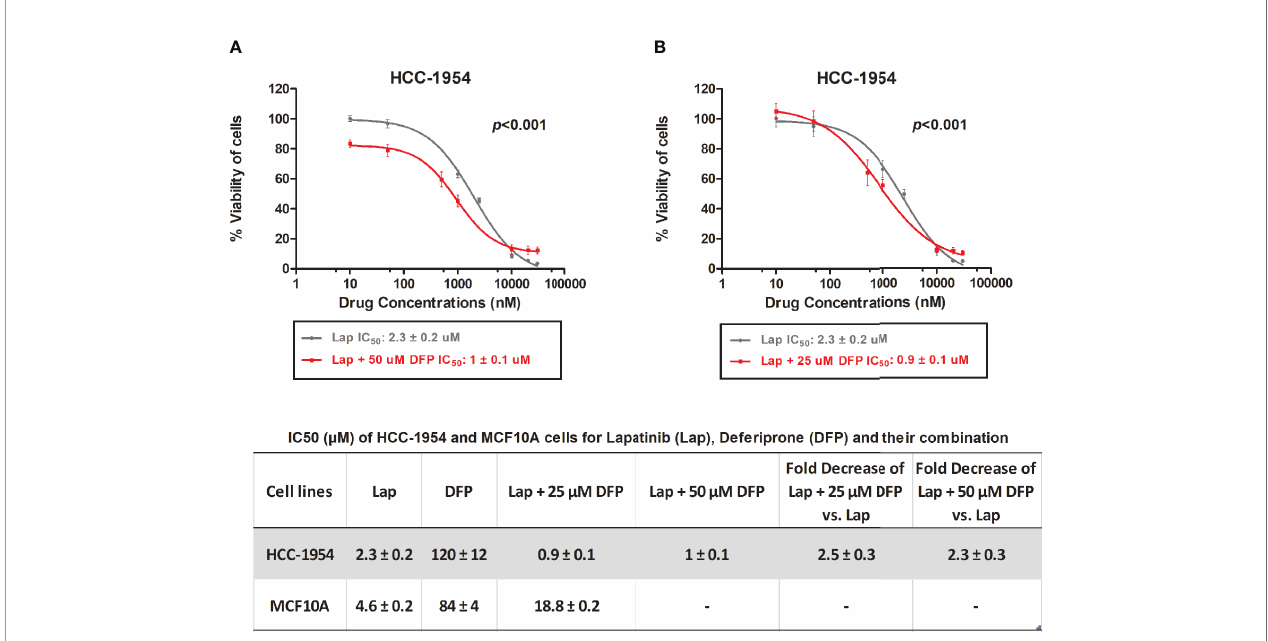
FIGURE 5 | In vitro MTT cytotoxicity of Lapatinib compared to combined treatment of Lapatinib and Deferiprone in HCC-1954 (HER2+) cells. (A) A synergistic cell growth inhibitory effect of Lapatinib in combination with 50 m M Deferiprone on HCC-1954 cells was found ( p < 0.001). (B) A similar synergistic cell growth inhibitory effect was determined for Lapatinib in combination with 25 m M Deferiprone on HCC-1954 cells ( p < 0.001). The results represent the mean values ± SD of three independent